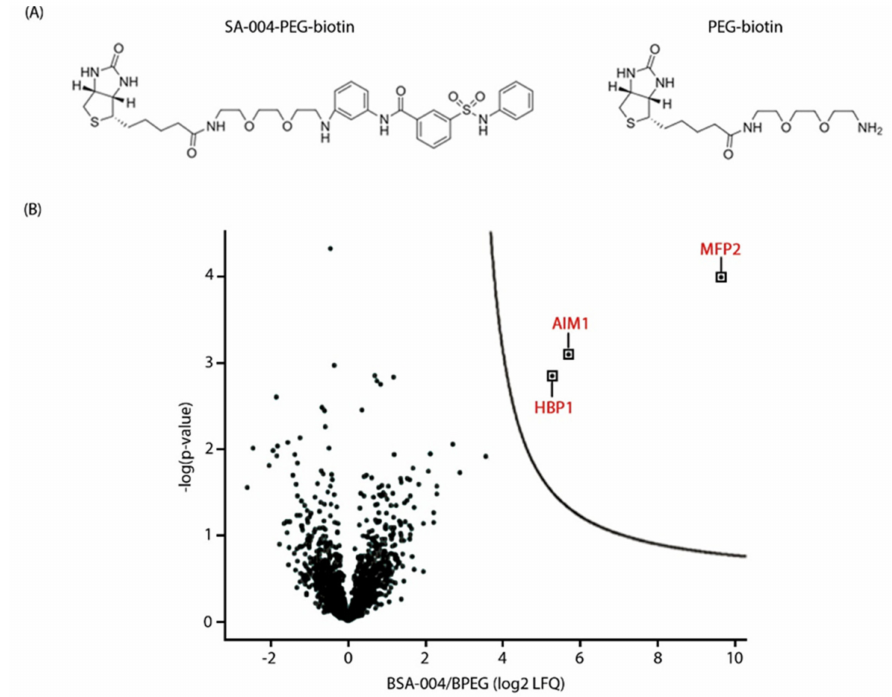
Figure 7. Abnormal inflorescence meristem 1 (AIM1) is a putative protein target of pakerine. ( A ) Chemical structures used for a ffi nity purification. The functionalized pakerine analogue SA004 fused to a polyethylene glycol (PEG) linker and coupled to a biotin tag at the end of the PEG chain (SA004–PEG–Biotin) was used to fish out putative protein interactions. A construct consisting of biotin attached to PEG (Biotin–PEG) was used to eliminated background proteins interacting with the matrix and the linker. ( B ) Proteins significantly enriched after a ffi nity purification. Protein isolates from Arabidopsis cell cultures ( n = 3) were incubated with SA004–PEG–Biotin and significantly enriched proteins in comparison to Biotin–PEG controls were identified (log 2 label-free quantification intensity (LFQ) > 3.5, p < 0.05).